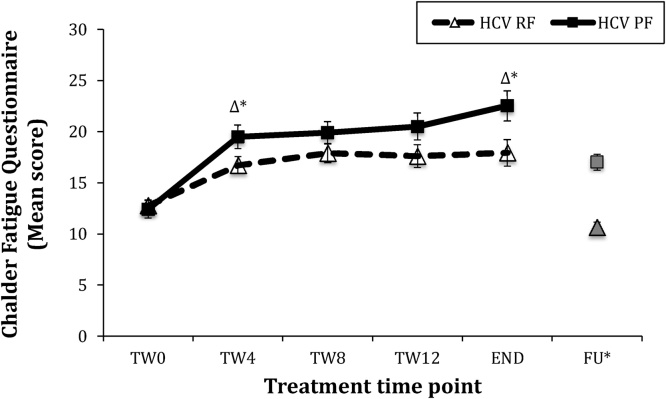
Fatigue scores in HCV Persistent Fatigue vs. Resolved Fatigue groups.Notes- error bars SEM; RF n = 29; PF n = 17; HCV – Hepatitis C Viral infection; Δ* - Δ vs. Treatment Week (TW)-0, p < 0.05; ‘END’ – composite end of treatment variable (see methods); TW8 & FU not included in ANOVA, included for illustrative purposes only.